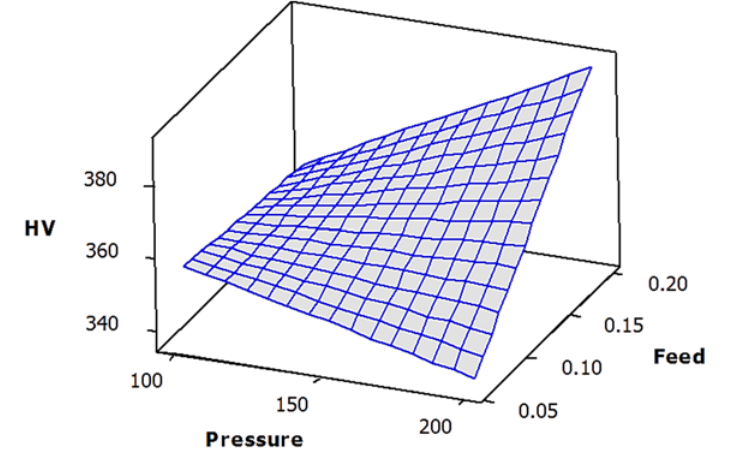
Figure 7. Response surface plot of microhardness vs. Feed and Pressure.